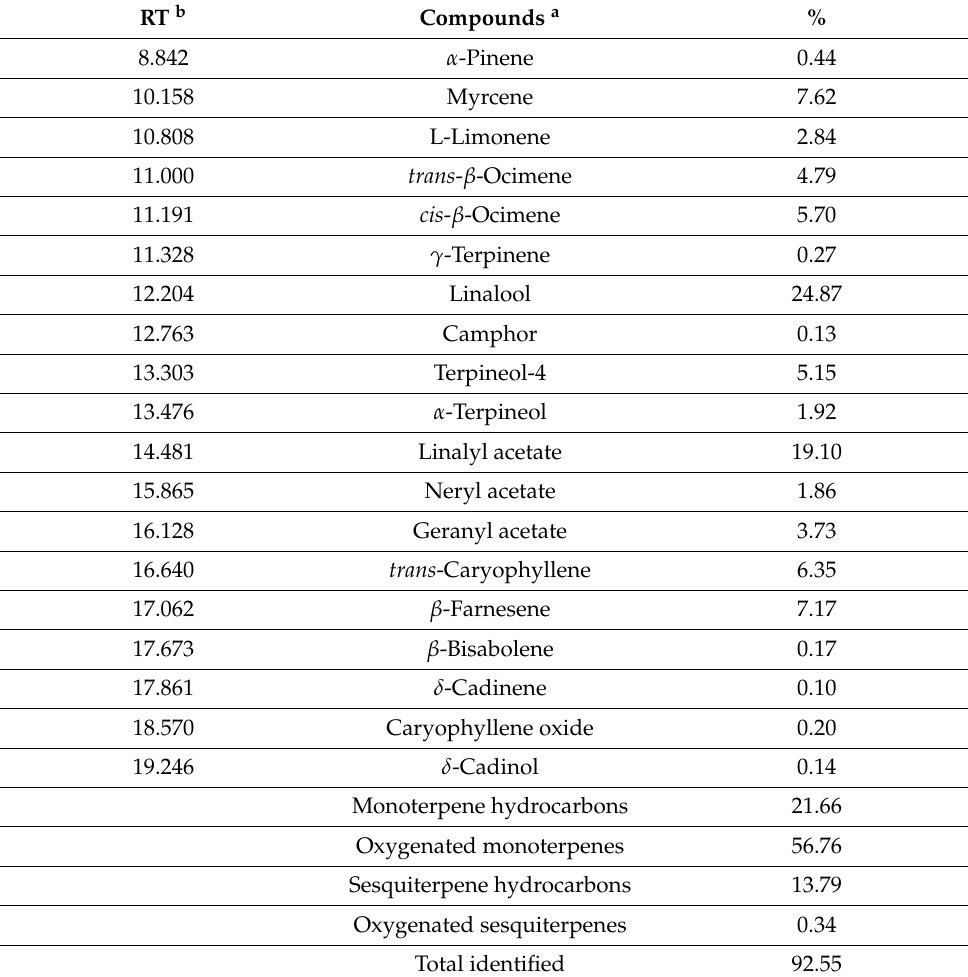
Table 2. Chemical composition of the volatile oil extracted from Lavandula stoechas using a steam distillation